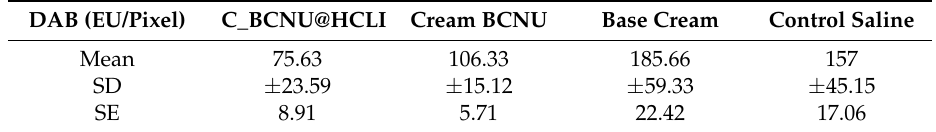
Table 5. Bcl-2 expression level: the difference between the means obtained by performing the two-tailed t -Student test for independent samples (unequal variances) and confidence interval set at 95%; (TIFFalyzer).